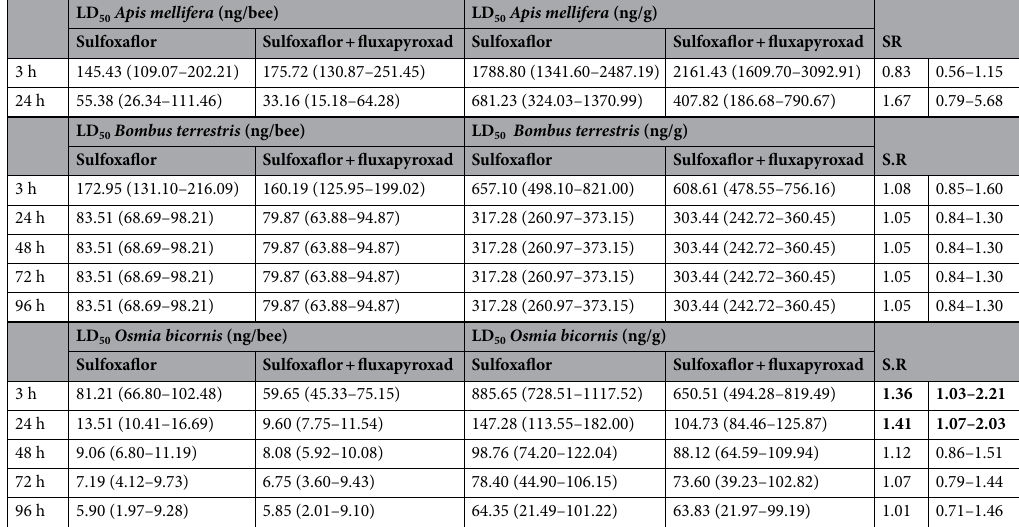
Table 1. LD50s and 95% confidence limits (in parentheses) expressed in ng bee −1 and in ng g −1 of bee body weight following acute oral exposure to sulfoxaflor alone and in combination with fluxapyroxad at different assessment times (3, 24, 48, 72 and 96 h after exposure). SR is the synergism ratio between the LD 50 of sulfoxaflor alone and in combination with fluxapyroxad. Significant SRs (SR higher than 1 and the two confidence intervals do not overlap “1") are in bold. LD 50 could not be determined for Apis mellifera at 48, 72 and 96 h because the Probit dose–response relationship at the tested doses was not